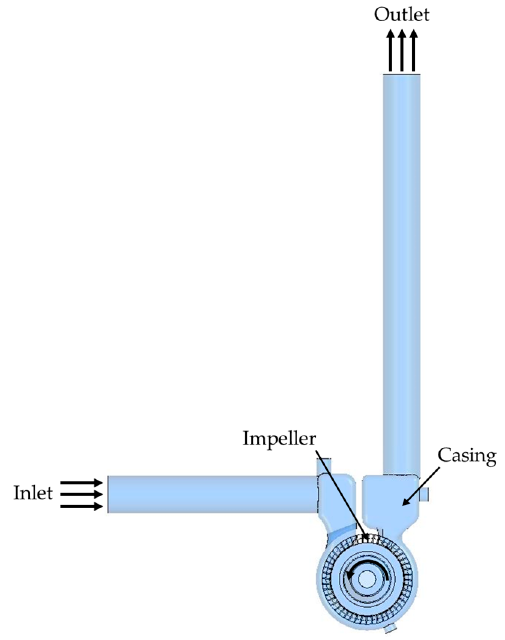
Figure 6. Computational domain of the microbubble pump.